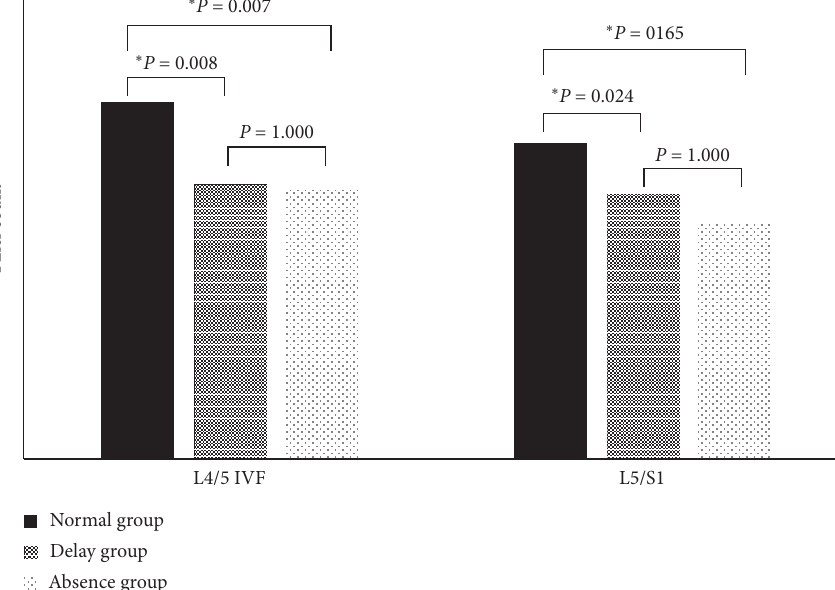
Figure 2: The post hoc analysis of IVF pixel counts in each group. ∗ p < 0 . 05. IVF, intervertebral